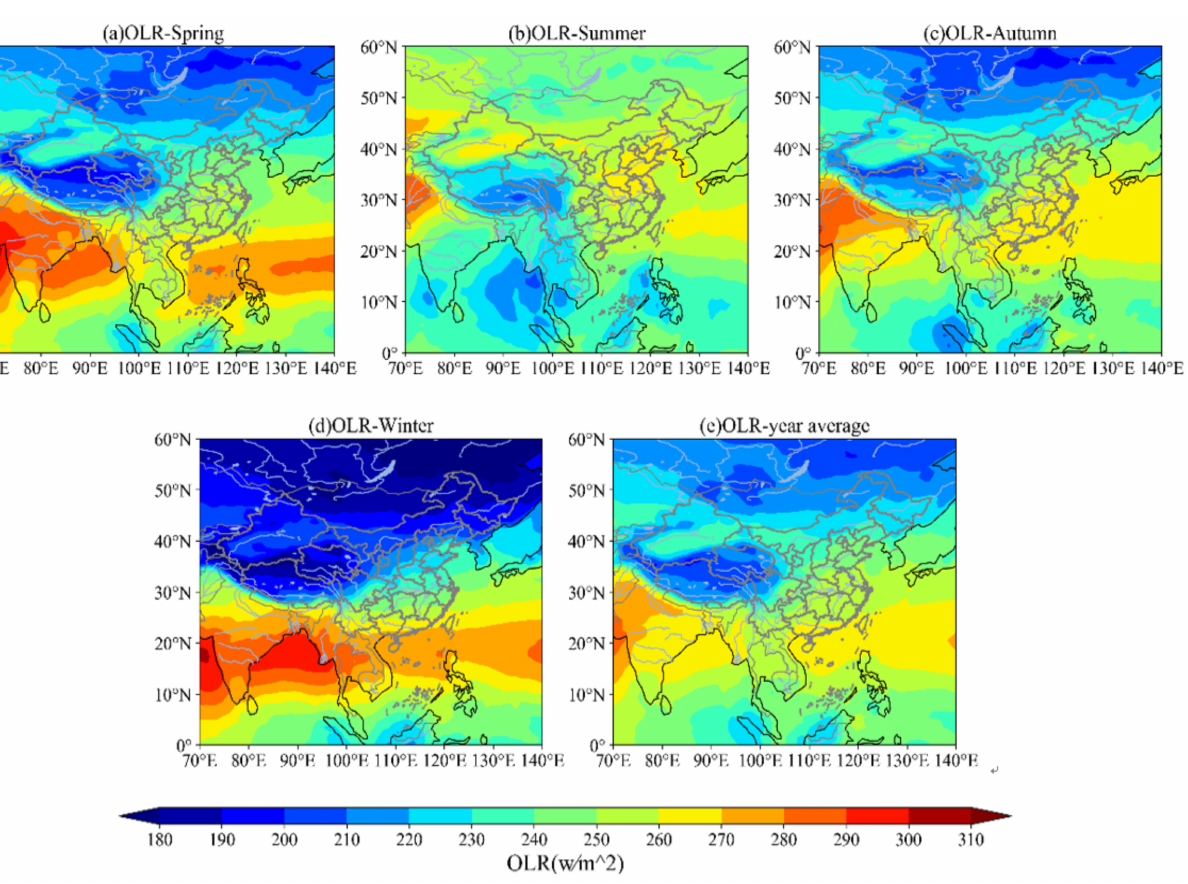
Figure 6. Spatial distribution of four seasons and multi-year mean OLR in China. ( a ) OLR-Spring. ( b ) OLR-Summer. ( c ) OLR-Autumn. ( d ) OLR-Winter. ( e ) OLR-year